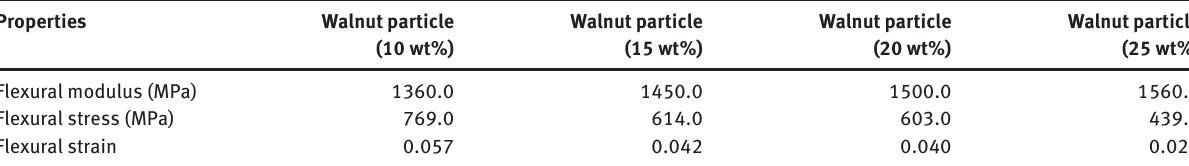
Table 6 Flexural strength properties for resin and composites